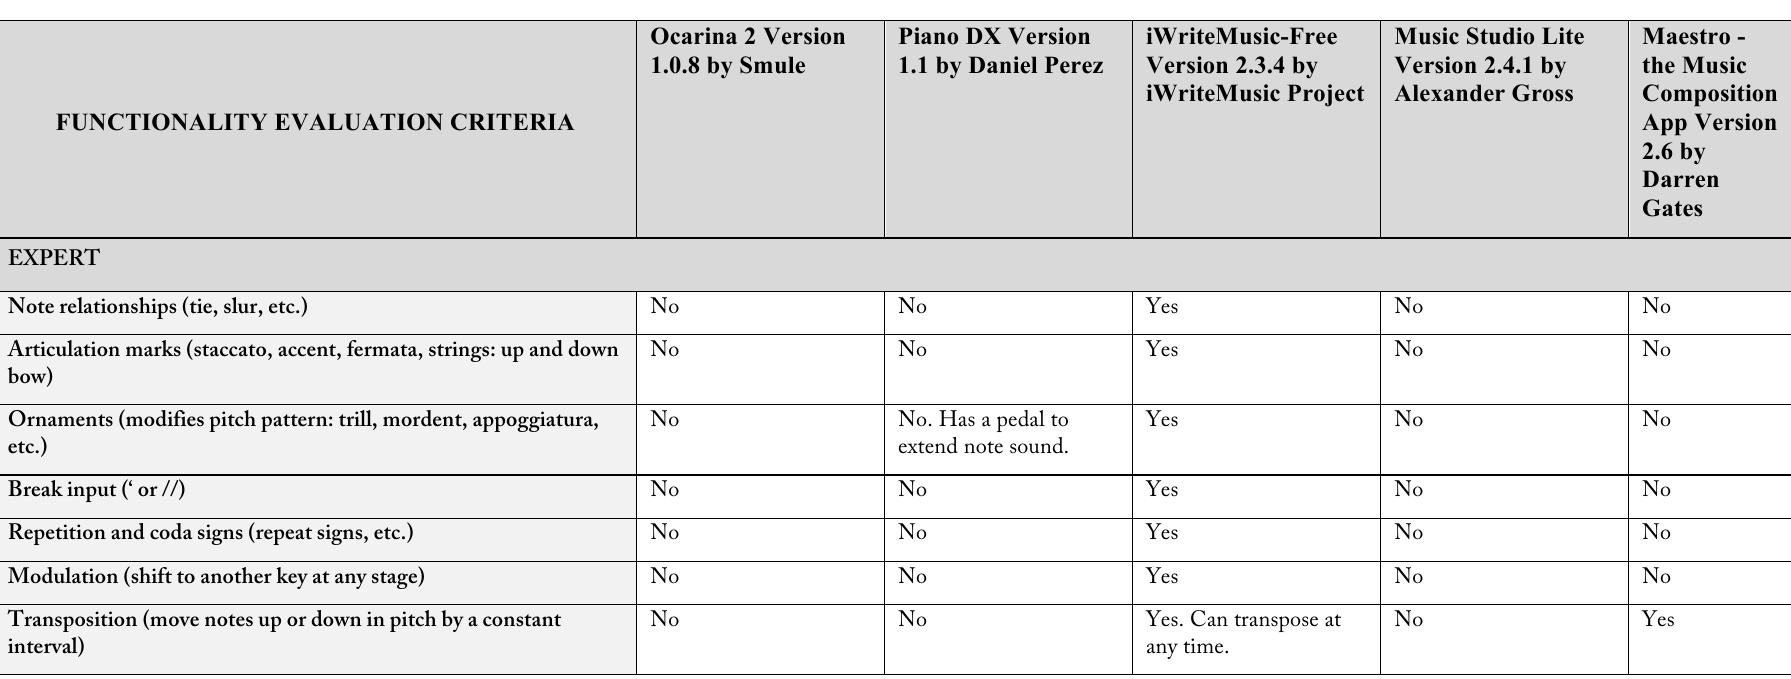
Table 5.1: A framework to evaluate mobile application functionality for music composition (applications